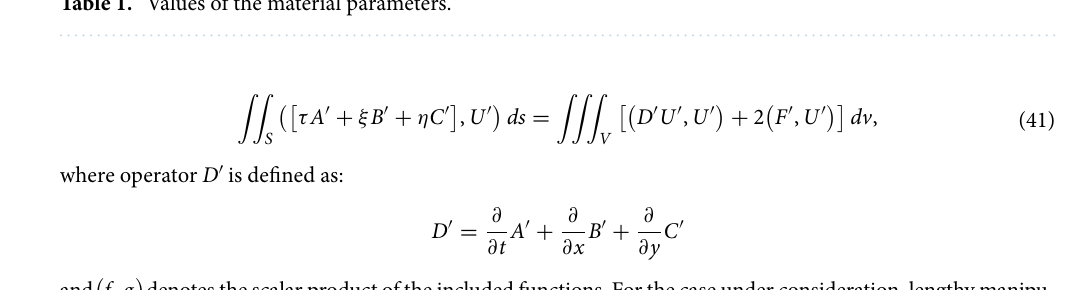
Table 1. Values of the material